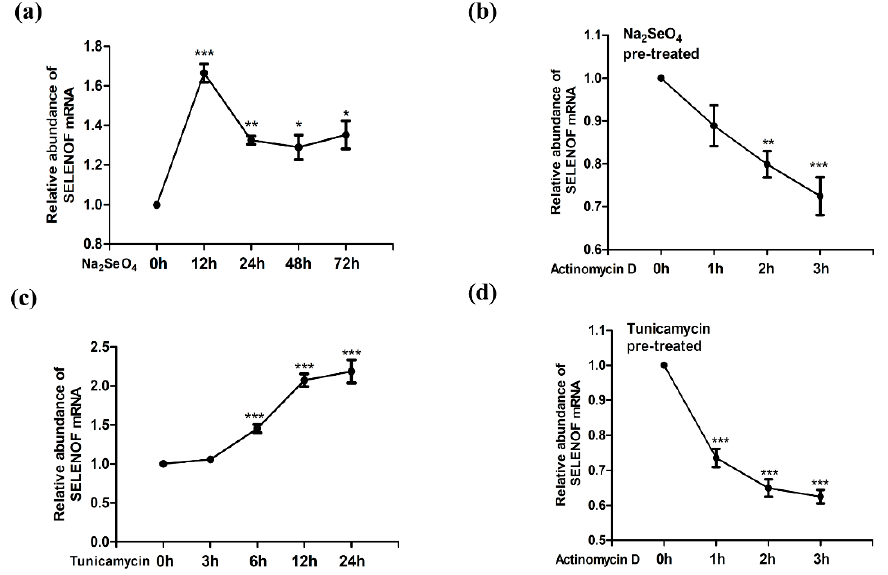
Figure 1. Selenoprotein F (SELENOF) mRNA up-regulation by selenate and tunicamycin (Tm). The transcription levels of SELENOF at several time intervals were quantified by Q-PCR in HEK293T cells ( a ) treated with selenate, ( b ) preconditioned with selenate then treated with Actinomycin D, ( c ) treated with Tm, and ( d ) preconditioned with Tm then treated with Actinomycin D. * p < 0.05, ** p < 0.01 and *** p < 0.001.